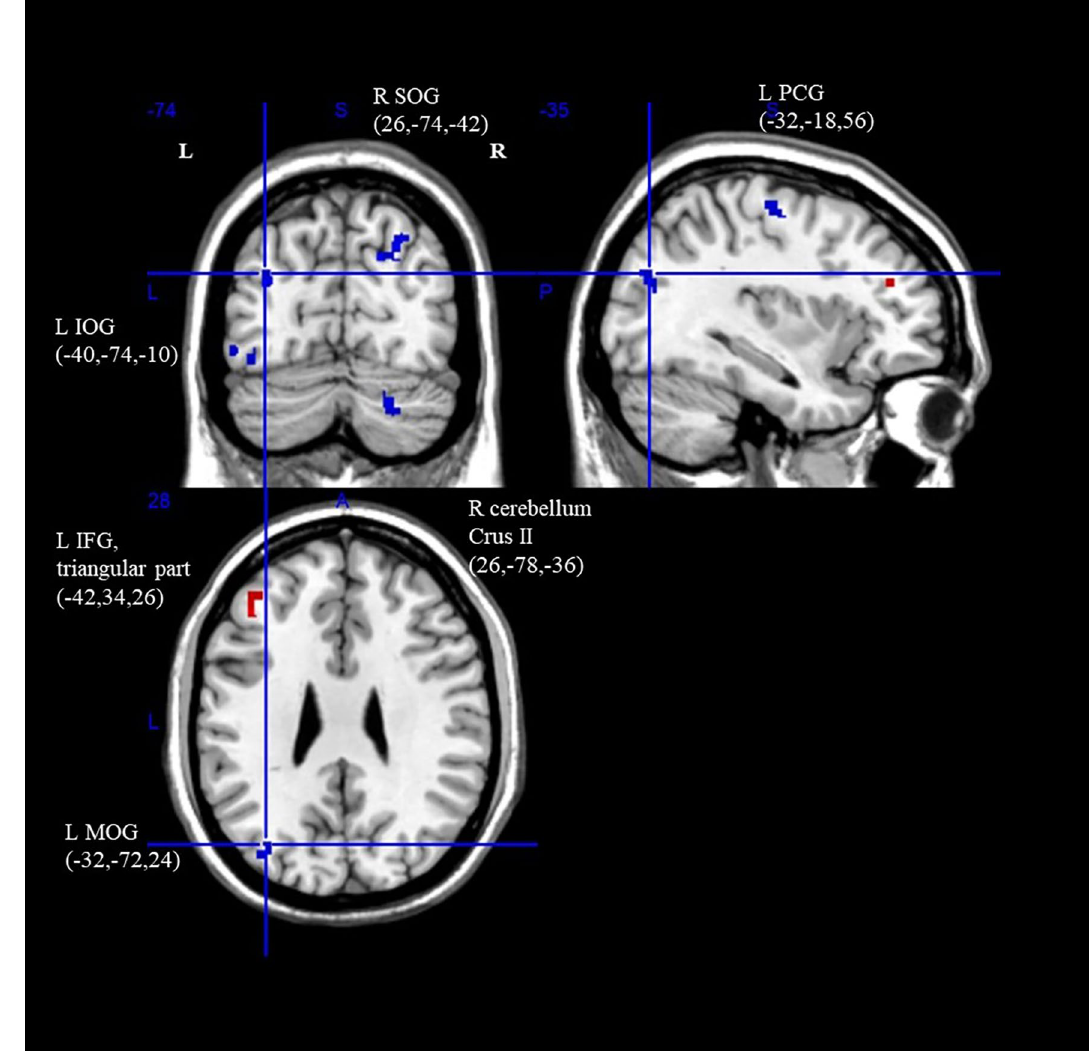
Figure 2. Differences in brain activation between ASD and HC during attentional control. Cluster with red and blue colours indicates hyperactivation and hypoactivation when compared with HC ( p < 0.005, uncorrected; L left, R right, SOG superior occipital gyrus, MOG middle occipital gyrus, IOG inferior occipital gyrus, IFG inferior frontal gyrus, PCG precentral